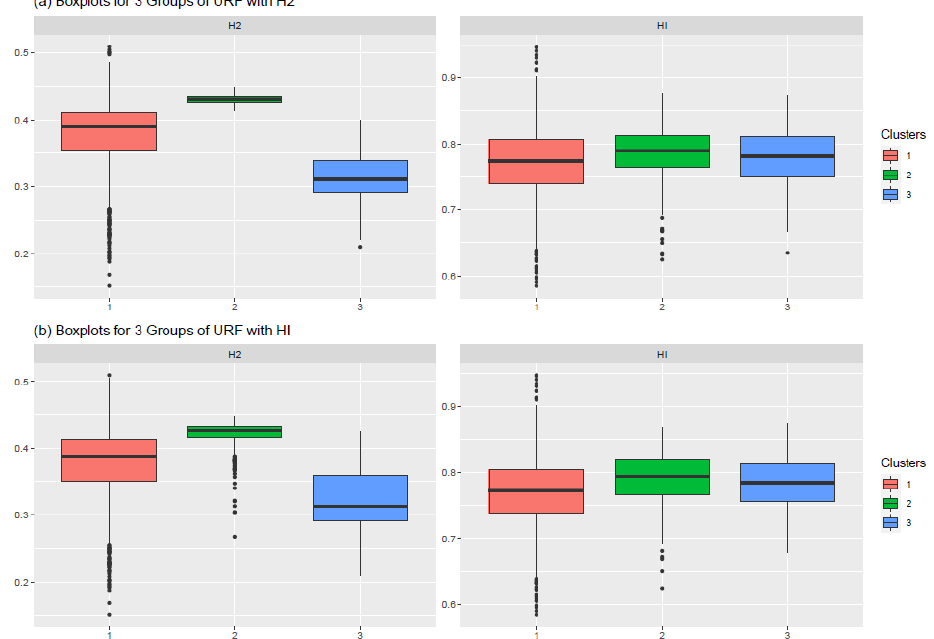
Figure 7. Comparison of H2 and HI for all clusters when URF was used with H2 ( top ) and HI ( bottom ) in all study areas.